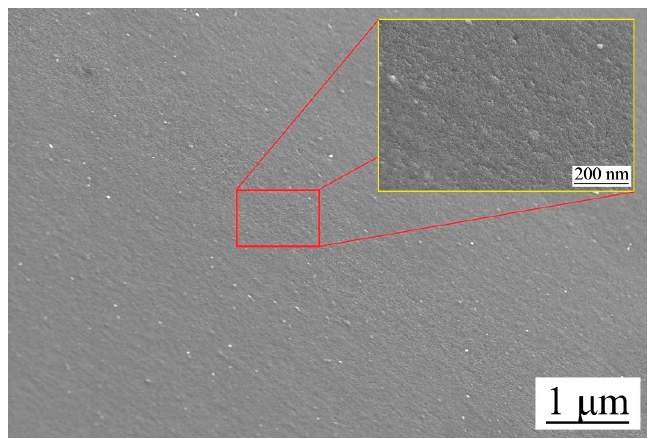
Figure 11. SEM diagram of the original mold after sputtering the Cr layer.